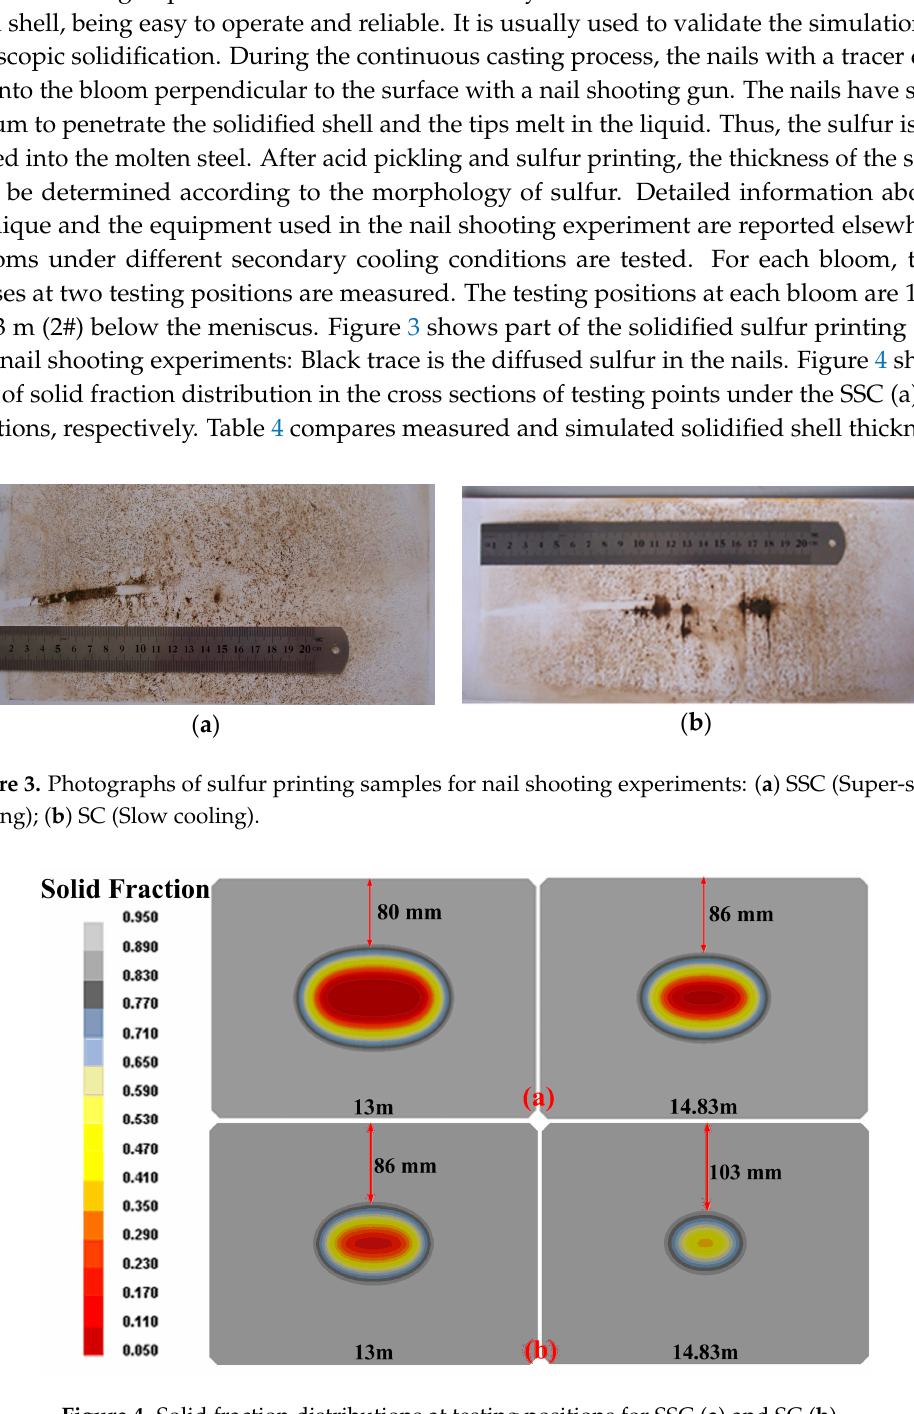
Figure 4. Solid fraction distributions at testing positions for SSC ( a ) and SC ( b ). Table 4. Comparison of measured and simulated solidified shell thickness.